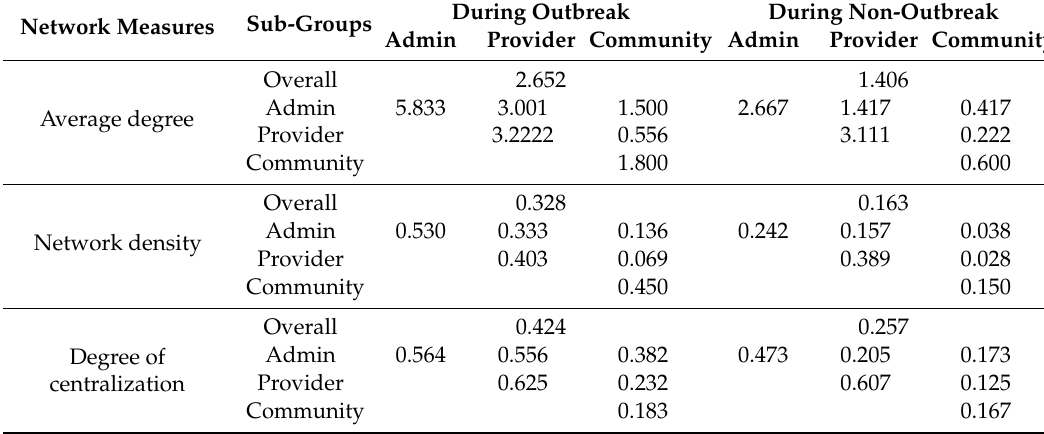
Table 2. Network strength of actors disaggregated by the health system level in the operational setting of Ahmedabad,